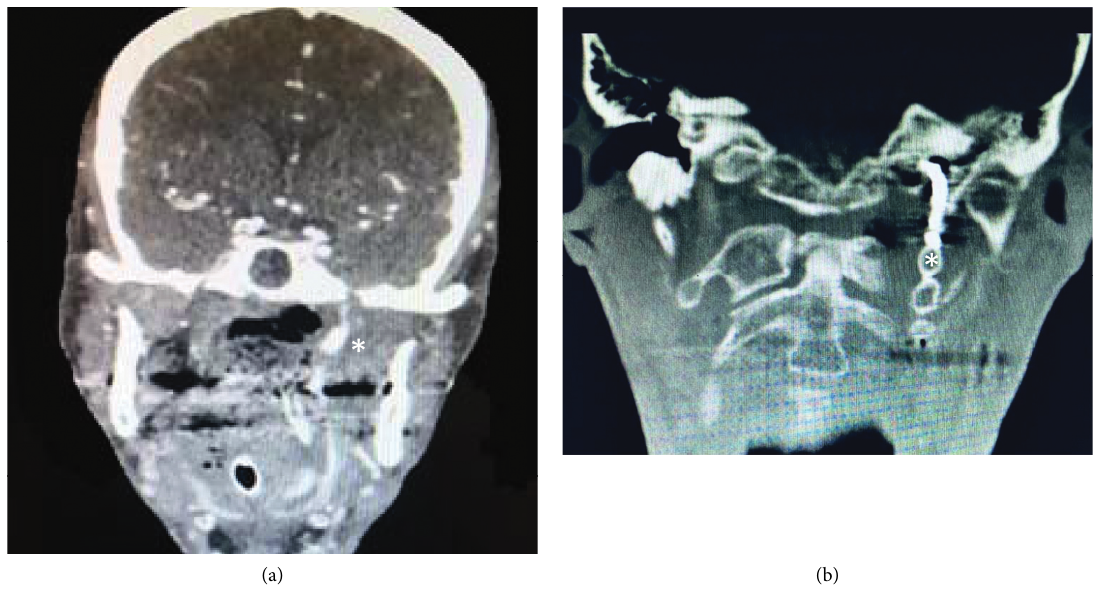
Figure 3: (a-b) Computed tomography after embolization and dislocation of the coil ( ∗ plug without coil). No extravasation was noted.